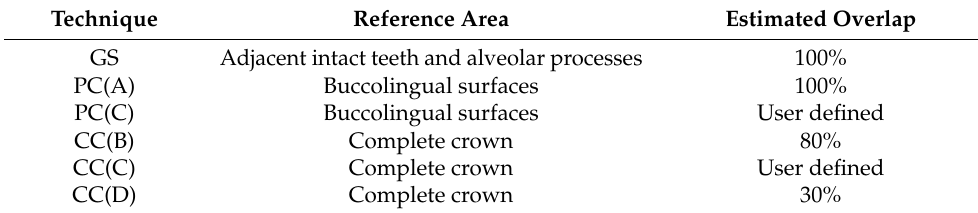
Table 1. Superimposition techniques tested in the